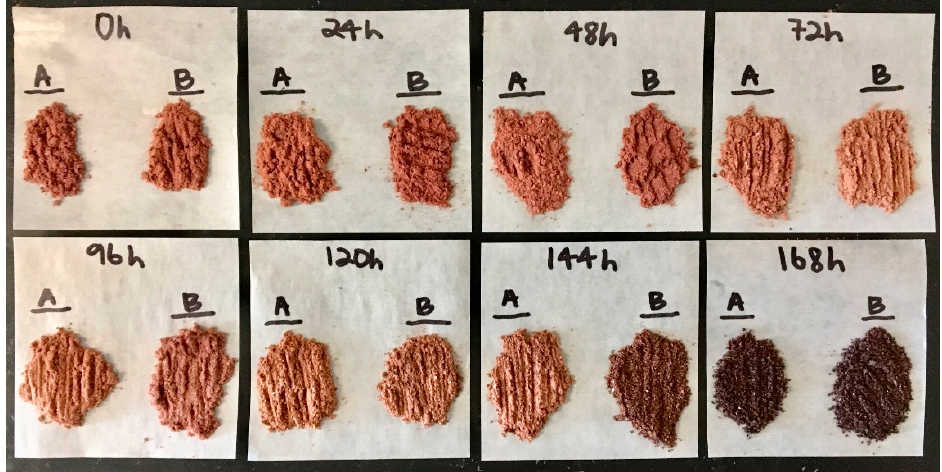
Figure 7. Polyphenol-rich cocoa extracts (CE) prepared at each point throughout the 168-h fermentation. See Section 2.8 for methodology. It is important to note the change in color and texture towards the final hours of fermentation.